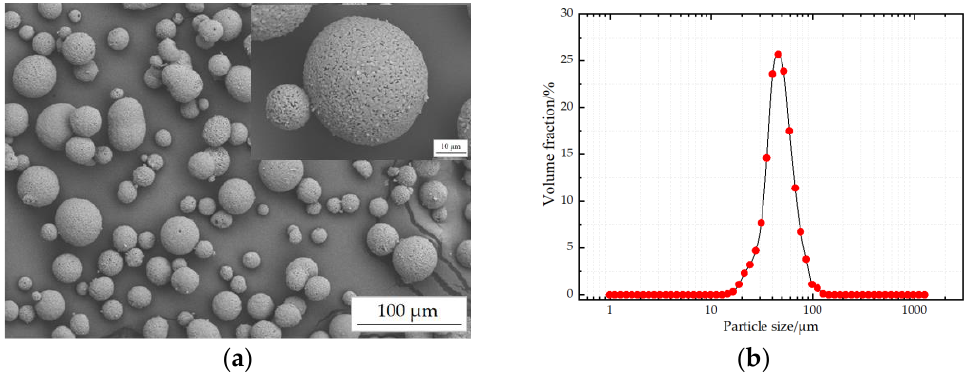
Figure 4. Morphology and size distribution of MgO-doped Al 2 O 3 powder. ( a ) morphology of MgO-doped Al 2 O 3 powder after spray drying. ( b ) particle sizes of MgO-doped Al 2 O 3 powder after spray drying.